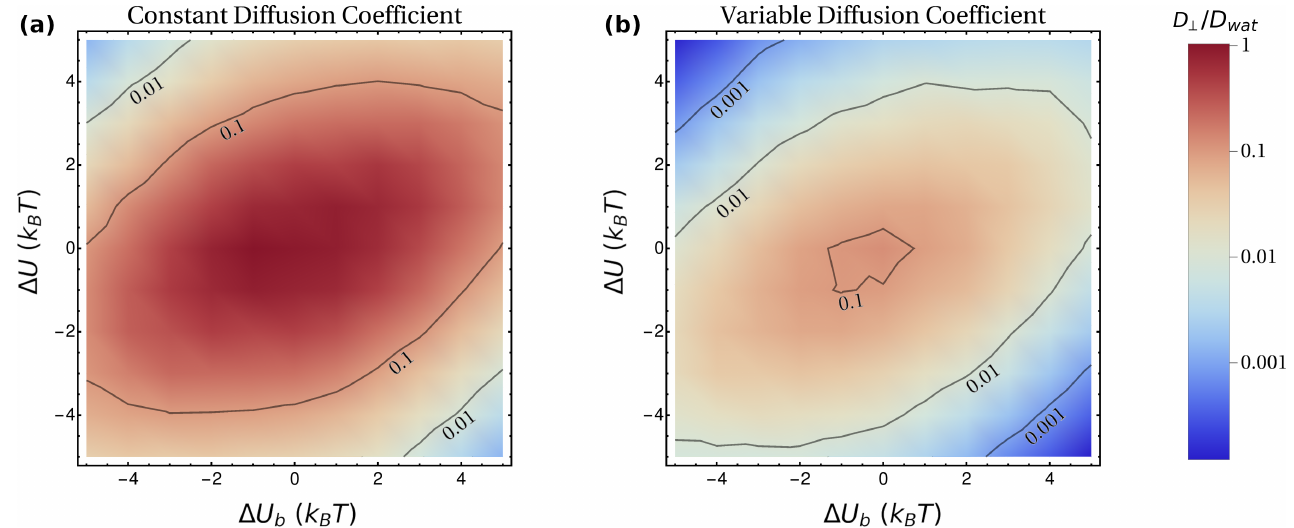
Figure 5. Dependence of the perpendicular long-time diffusion coefficient D ⊥ on hydropathy ( ∆ U ) and affinity for lipid heads ( ∆ U b ), implemented according to the corresponding potential of mean force U ( z ) (Figure 1a); ( a ) is obtained by assuming D lip = D wat , while ( b ) considers a more realistic diffusion profile with D lip = 0.09 D wat (Figure 1c). The contours correspond to the indicated values of D ⊥ / D wat